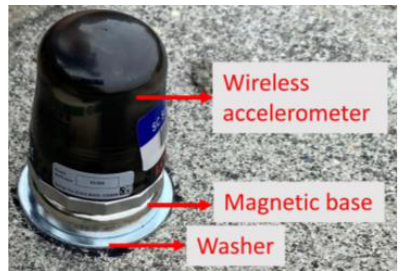
Figure 5. A wireless accelerometer installed on the girder’s top surface.